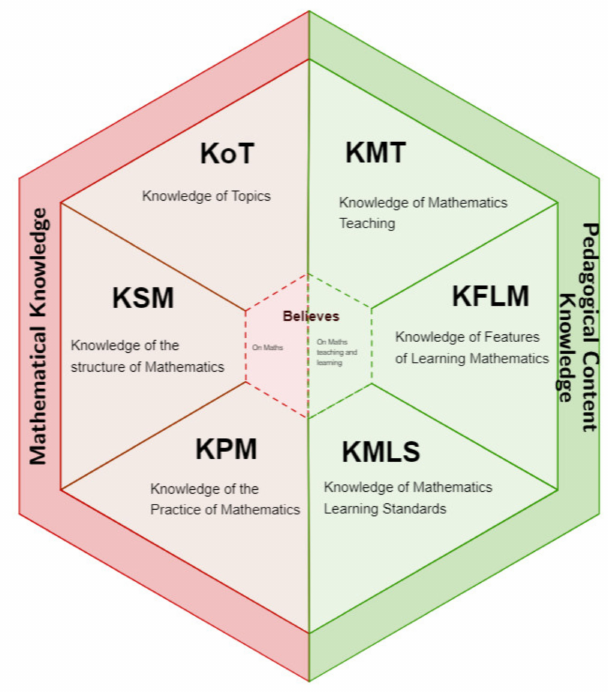
Figure 1. Mathematics teachers’ specialised knowledge (elaborated from